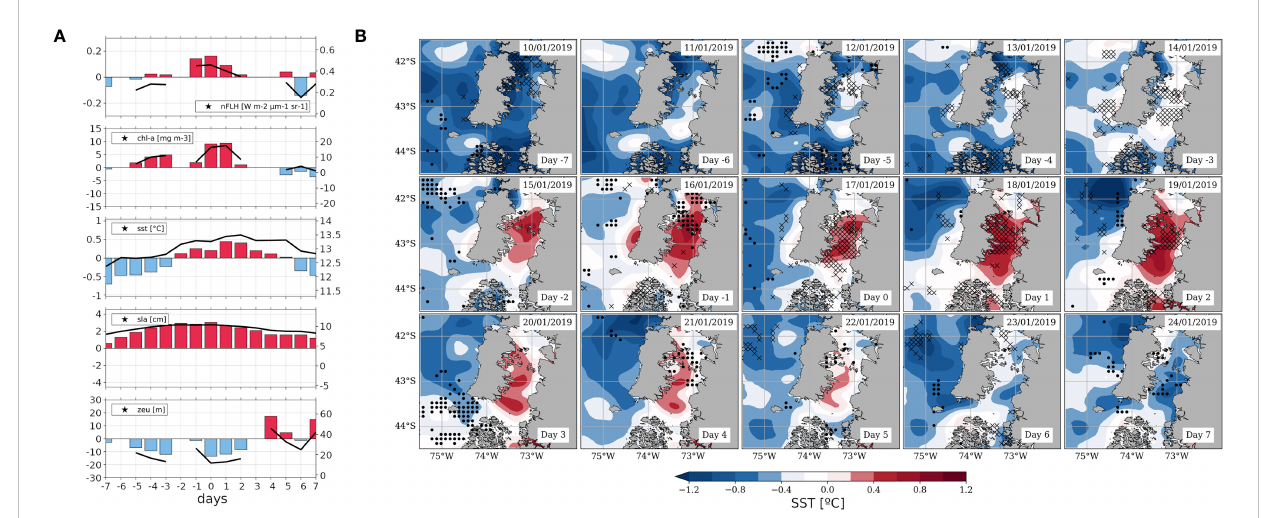
FIGURE 8 As Figure 5, but referred to the case study around the HBE of January 17, 2019 (day 0). (A) Time series calculated as fi eld averages within the S-ISC subregion (42.5°-43.5° S; see Figures 1A) for a sequence of days centred on the HBE onset, i.e., on day 0, spanning from day -7 to day +7. Variables correspond to nFLH [W m -2 µm -1 sr -1 ], CHLA [mg m -3 ], SST [°C], SLA [cm] and ZEU [m]. The right-hand y-axis of each panel shows the absolute values on solid black lines centred around the mean DJF value (central horizontal line), while the left y-axis shows the positive (negative) SY-IS anomalies on red (blue) bars centred around 0. (B) Maps centred on day 0, spanning from day -7 to day +7, showing SST ’ ( fi lled contours, see colour scale), ZEU' [for graphical convenience with respect to the SST ’ pattern, crosses (dots) depict shoaling (deepening) anomalies below -14m (above 14m)].